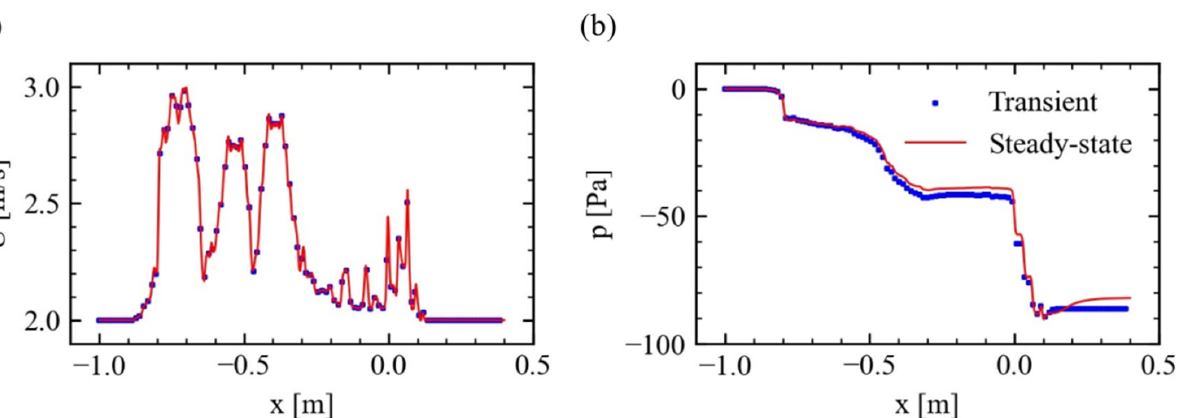
Figure 8. ( a ) Distribution of the y + over the server and ( b ) histogram plot of the y + in the computa ‐ tional domain.